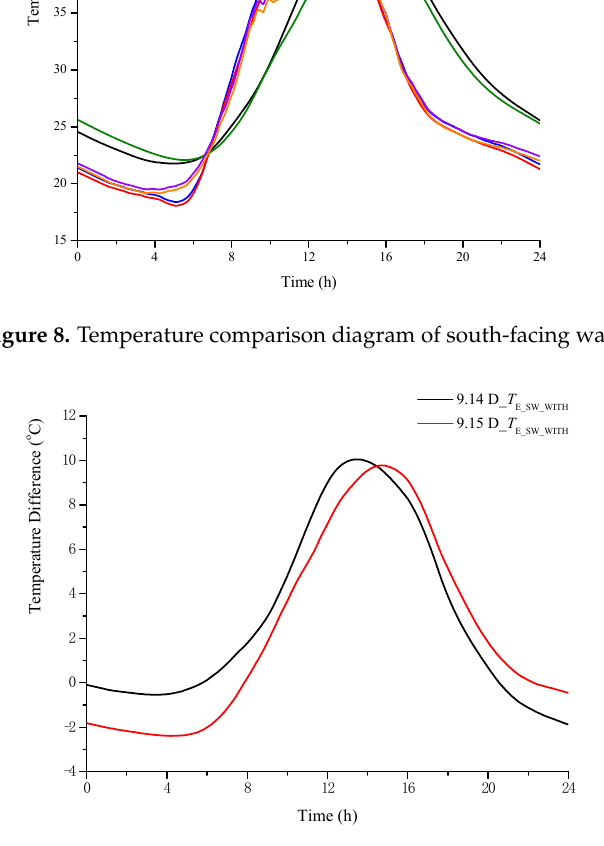
Figure 9. Variation curve of temperature difference between exterior and interior surfaces of south-facing wall of experimental room.